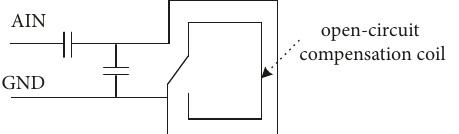
Figure 6: The circuit diagram of the POS RF part.